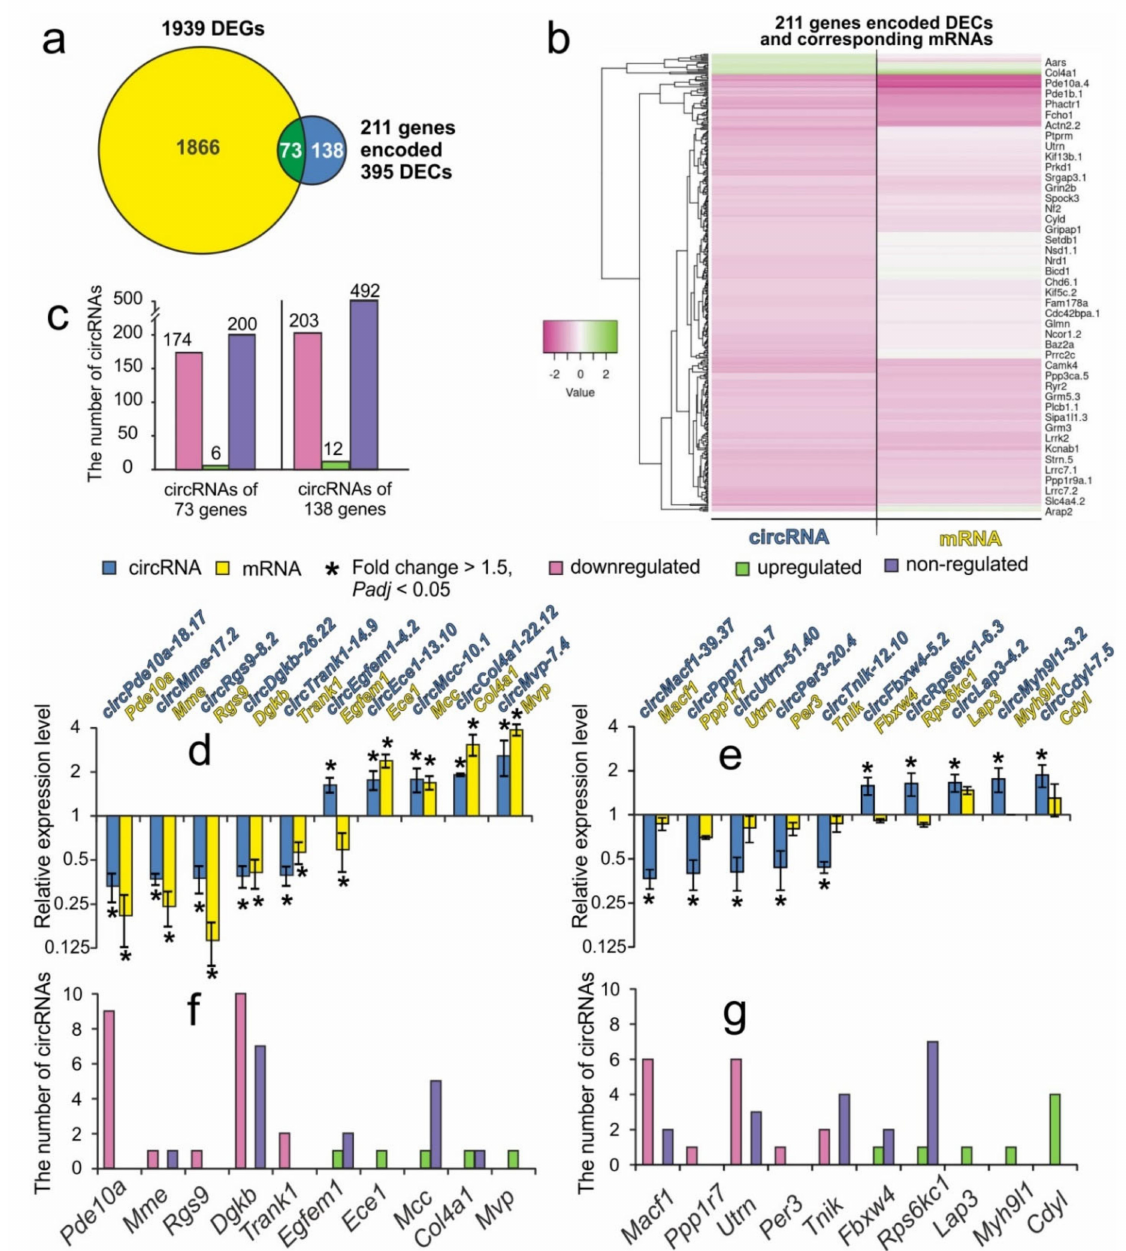
Figure 4. Comparative analysis of circRNAs and mRNAs expression changes at 24 h after tMCAO. ( a ) Schematic comparison of the transcriptome circRNA and mRNA profiles obtained in pairwise comparison IR24 versus SH24 by Venn diagram. The numbers in the diagram sectors indicate the number of genes that encoded DECs and the number of genes that encoded DEGs. ( b ) Diagrams showing genes that encode circRNAs and that lie within the diagram segments on the Venn diagram ( a ). The numbers above the bars indicate the number of circRNAs. ( c ) Hierarchical cluster analysis of genes, encoded DECs and corresponding mRNAs in IR24 versus SH24. Each column represents a comparison group, and each row represents a gene. Green strips represent high relative expressions and pink strips represent low relative expressions, n = 3 per group. ( d , e ) Changes in expression level of circRNAs and mRNAs in IR24 versus SH24 for the top ten genes that lie within the diagram segments on the Venn diagram. The top ten genes that encoded DECs and that exhibited the greatest fold change in expression, as well as encoded DEGs ( d ) or non-significantly regulated mRNAs ( e ) are shown. The cut-off of RNA expression changes was 1.50. Only those RNAs with Padj < 0.05 were selected for analysis. ( f , g ) The numbers indicate the circRNAs that are up-, down-, or non-DECs in IR24 versus SH24 and that originated from group 1 ( f ) or group 2 ( g ) genes,